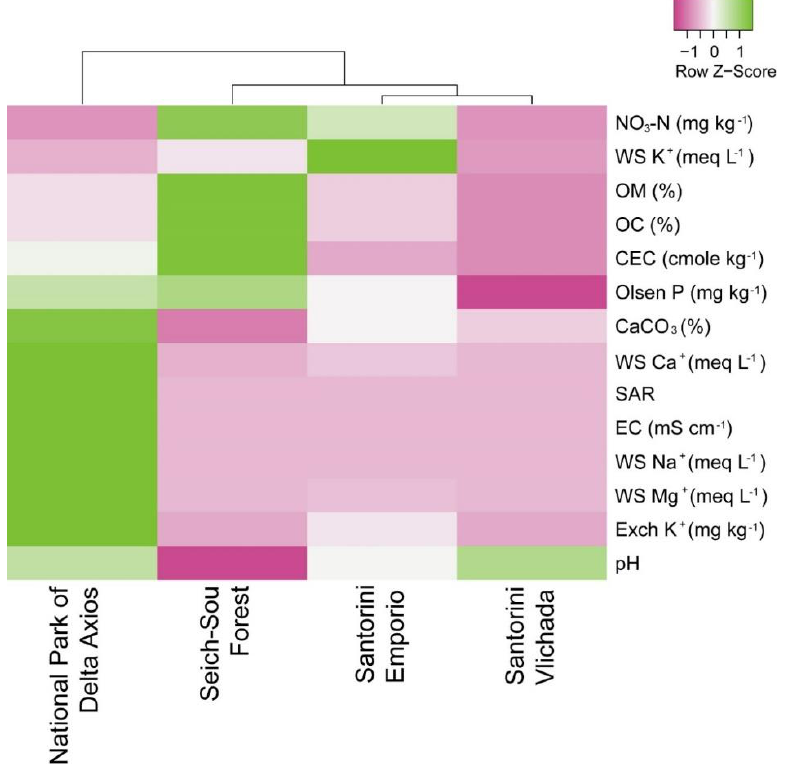
Figure 1. Heatmap of the chemical properties of the soils collected from sampling sites. Columns are mean centred with pink colouring representing low values, and green colouring representing high values. The Average Linage clustering method with Euclidean distances was used to cluster the sampling sites (in respect to soils’ properties). WS, water soluble; OM, Organic Matter; OC, organic C; CEC, Cation Exchange Capacity; SAR, Sodium Absorption Ratio; EC, electrical conductivity of the saturation extract; Exch., exchangeable.